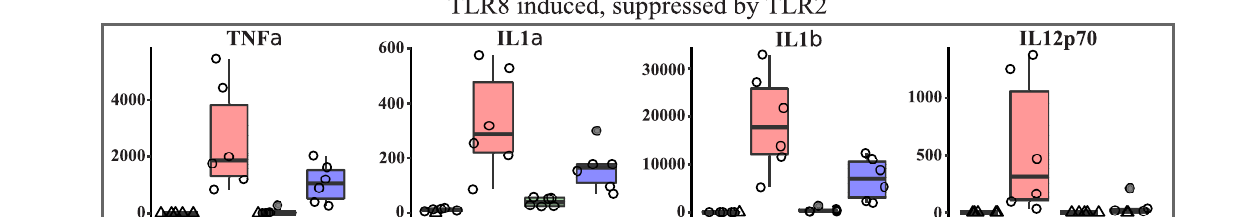
FIGURE 4 | Differential cytokine secretion after TLR8, TLR2, and co-stimulation. Human primary monocytes were stimulated as earlier and supernatant was collected after 6 h and analyzed by bioassay ( n = 6). (A) The differences in gene expression presented in Figure 2 is also evident in cytokine production and release, but while TLR2 is less potent to drive gene expression it is as or more potent at releasing some cytokines. Co-stimulation also notably induce higher amount of certain cytokines, especially those involved in neutrophil stimulation and attraction such as IL8 and IL23A. (B) Plotting the measured cytokine levels in a radar plot gives three overlapping but distinct cytokine profiles of the different stimulation status. Significance values are provided in Supplementary Table S3 .